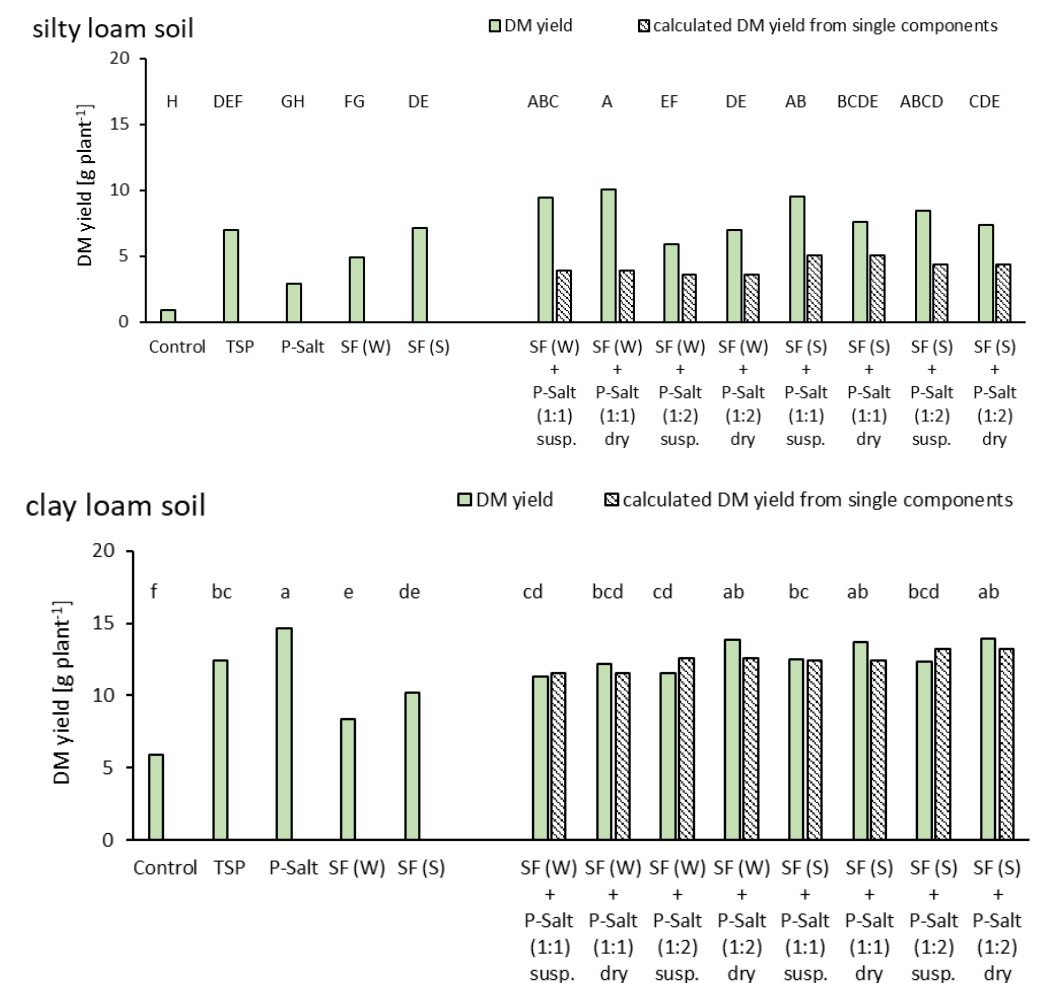
Figure 3. Mean shoot dry matter yield of maize (DM yield) in g plant −1 after soil treatment with different recycled digestate fertilizers in a total dose equivalent to 150 mg P (kg soil −1 ). Fertilizer fractions tested were P-Salt (P-enriched precipitate from the liquid fraction), SF (W) (air-dried solid fraction), SF(S) (steam-dried solid fraction), and different combinations of them, compared to unfertilized control and triple superphosphate (TSP). Maize plants were cultivated for 50 days in a silty loam and clay loam soil. Based on the total fertilizer dose corresponding to 150 mg P (kg soil −1 ), designation 1:1 means that fertilizers were applied with a mass portion of SF (W or S) containing 75 mg P (kg soil −1 ) + a mass portion of P-Salt containing 75 mg P (kg soil −1 ); likewise, 1:2 means using a mass of SF (W or S) with 50 mg (kg soil −1 ) + a mass of P-Salt with 100 mg (kg soil −1 ). The application technique “susp.” (suspended) describes that both components were pre-mixed and homogenized with 50 mL water in a vessel before being homogenized into the soil; “dry” means that the solid fraction SF was first mixed into the soil followed by the P-Salt, both without water. “Calculated DM yield from single components” represent a mathematical calculation of the combinations based on the results of the measured DM yield of each single component (P-Salt, SF(W), SF(S)) to indicate possible additive effects (material and methods: evaluation of synergistic effects Equations (1) and (2)). Data are means of four replicates each. Different letters denote significant differences (two-factorial Tukey’s test with p ≤ 0.05). Lowercase letters for the clay loam indicate that, in this case, all treatment groups were significantly different from those of the silty loam with the same treatment.